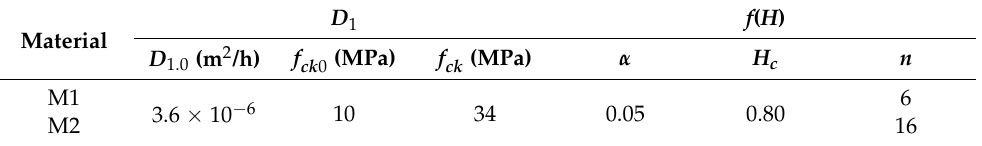
Table 1. The parameters of the moisture diffusion model for virtual